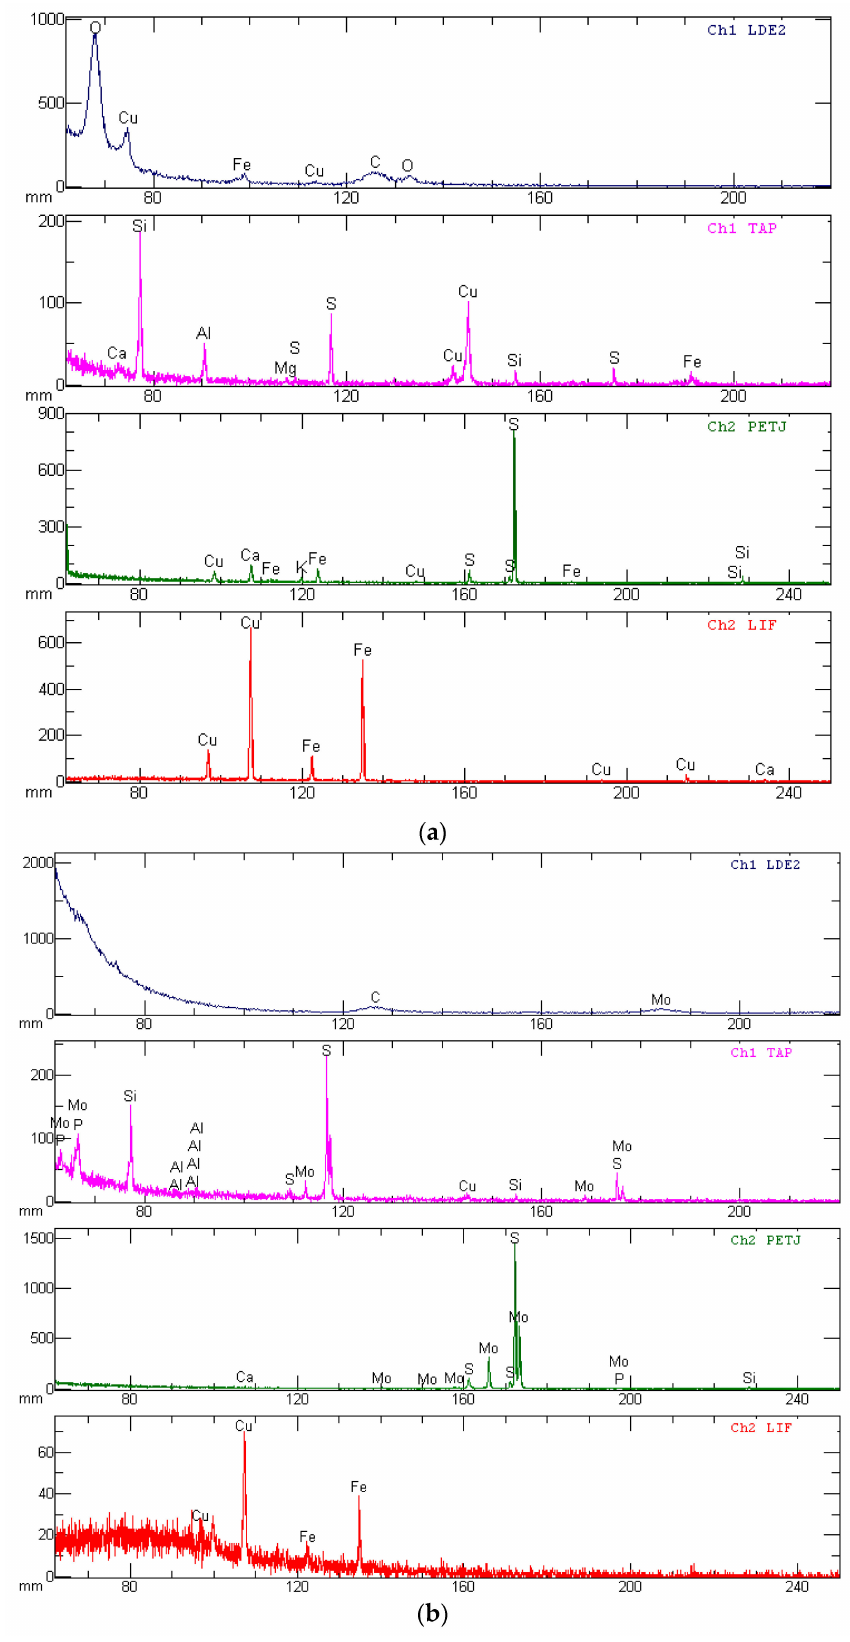
Figure 6. Results of wave-dispersive microanalysis of the Cu–Mo concentrate sample. Probe